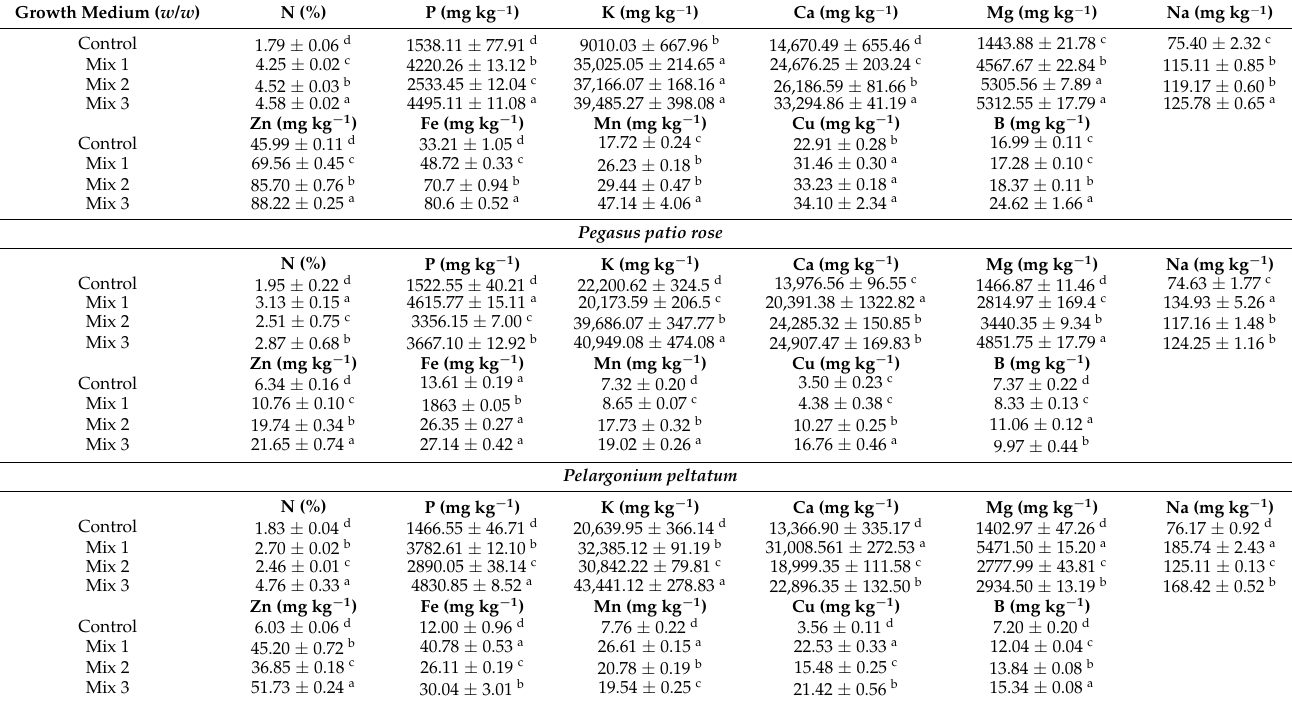
Table 2. Effects of vermicompost applicant on macro- and micronutrient content of Vinca rosea valiant , Pelargonium peltatum and Pegasus patio rose plants (90